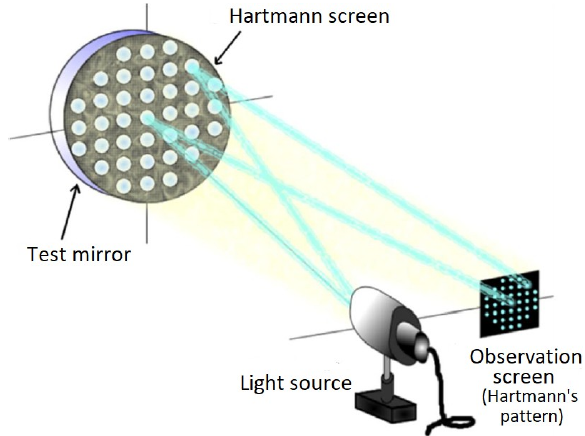
Figure 2. Hartmann test applied to optical elements.